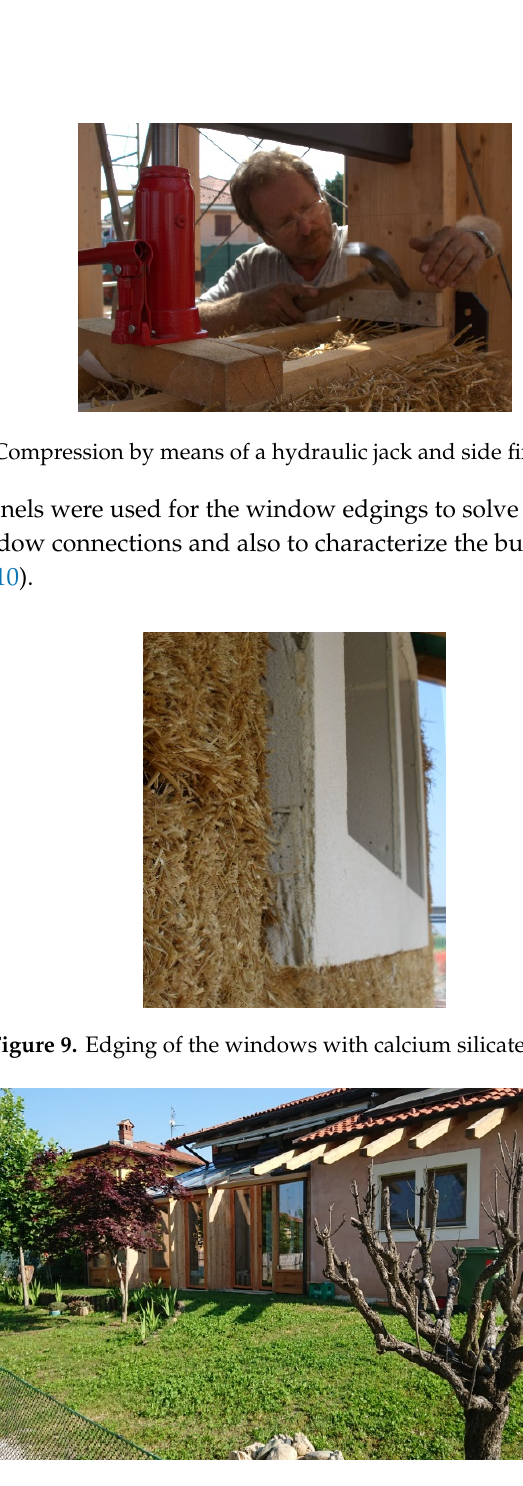
Figure 10. Aesthetic effect of the calcium silicate frame.